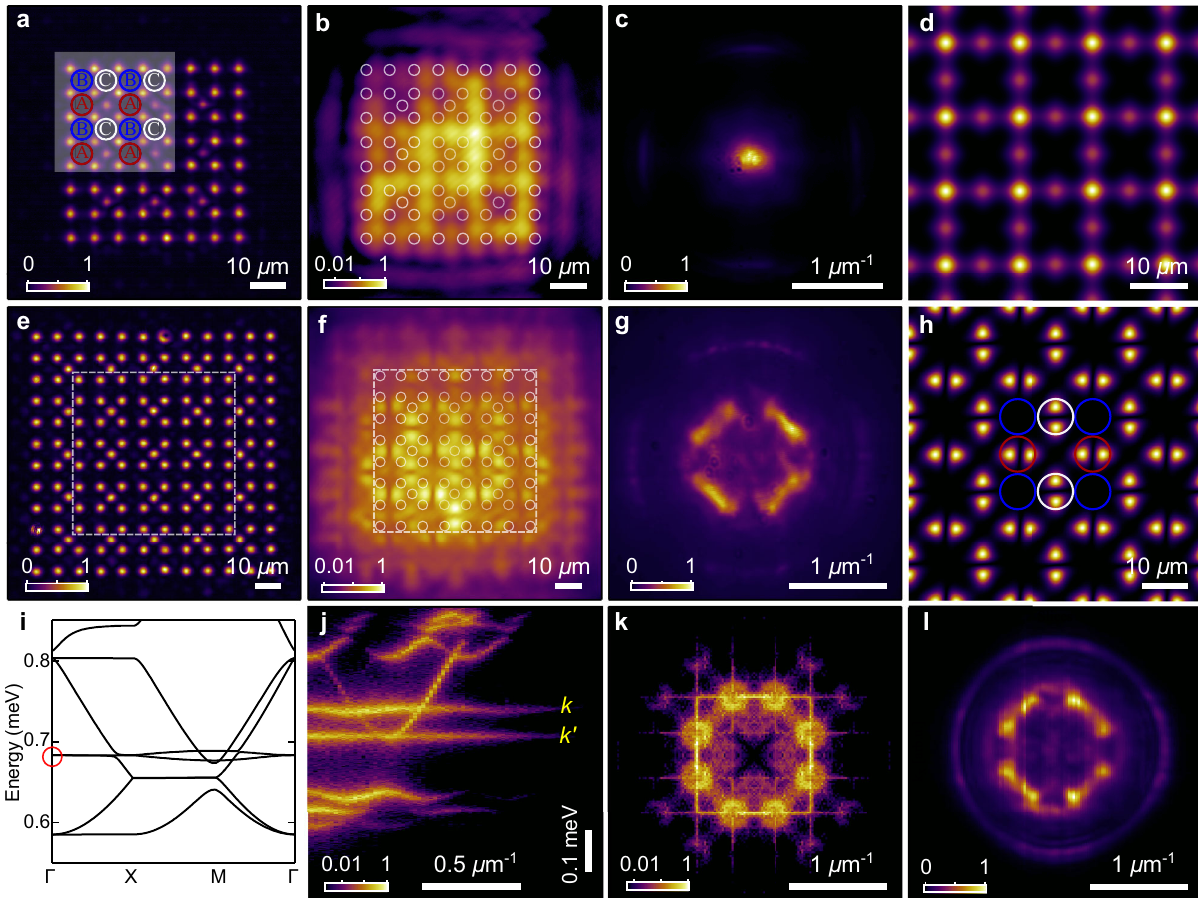
Fig. 4 Optical inverse Lieb lattice of Gaussians with fl atband condensation. a , e Spatial pumping pro fi le of Gaussian spots arranged in the inverse Lieb geometry with lattice constants D = 13 and 16 μ m, respectively. In a the cube-centred spots are 40% weaker in intensity compared to the rest of the pump spots. In e all spots are equally intense. b , f Real and c , g momentum space polariton PL above condensation threshold corresponding to populated S-band ground state and P- fl atband state, respectively. White circles in b , f denote the pumps positions. d , h Corresponding calculated real space wavefunction densities intensities from Bloch ’ s theorem. Coloured circles in a , h denote the Lieb lattice unit cells. i Calculated P-bands from Bloch ’ s theorem where the red circle marks the fl atbands. j Calculated dispersion cross-section at k x = 2 π / D from Monte-Carlo Schrödinger numerics. Both i and j use the pump pro fi le shown in ( e ). k , l Calculated and measured PL from the isoenergy plane in momentum space corresponding to the P- fl atband marked with the yellow letter k in ( j ). The band marked with the yellow letter k' is the lowest energy P-band which only appears fl at between the Γ - X points in the Brillouin